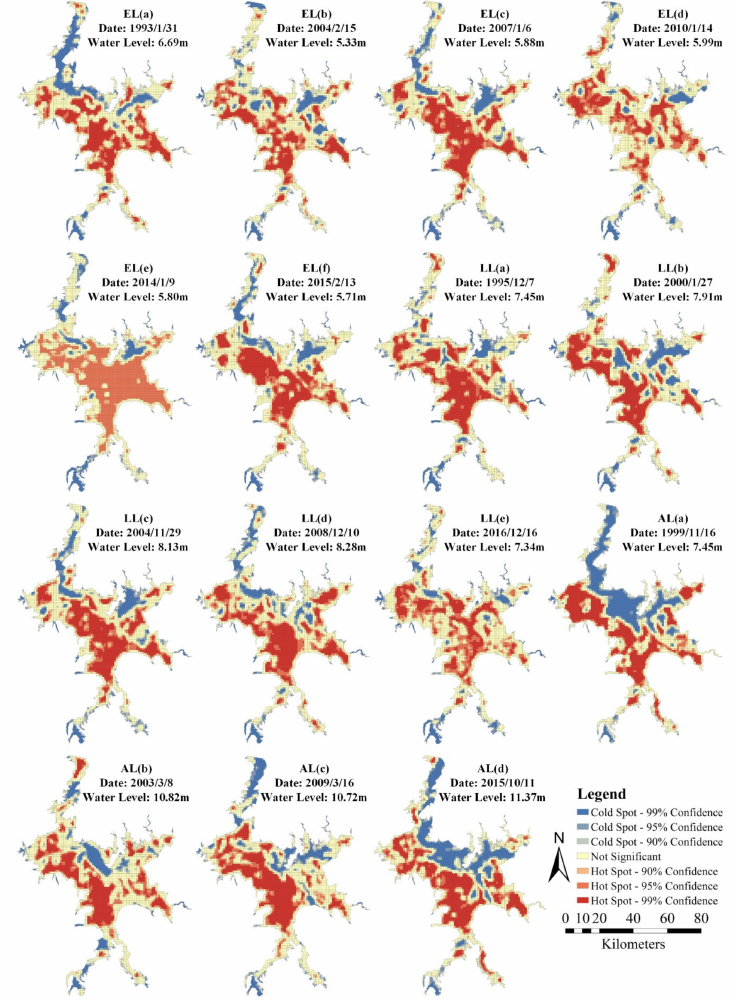
Figure 5. Hot and cold spots of the crane habitats in the Poyang Lake wetland found under different water levels at various dates (EL: extremely low level; LL: low level; AL: average